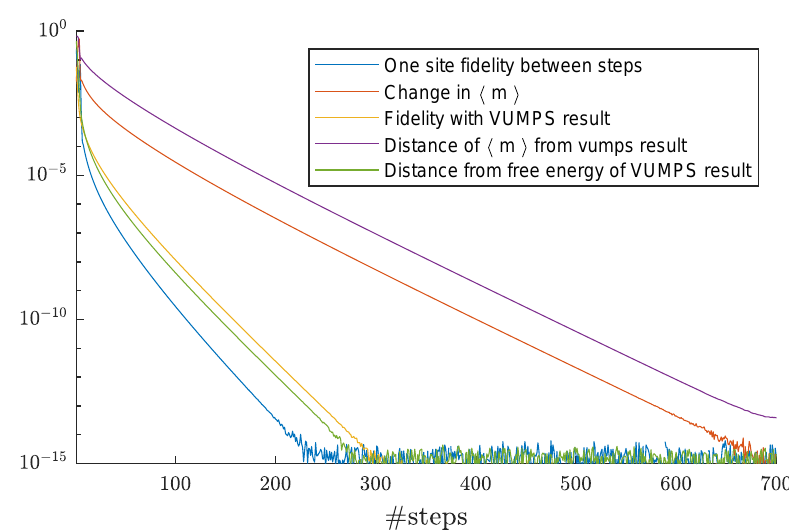
Figure 3: Different error measures to determine the convergence of the power method approach to find the MPS fixed point of the MPO transfer matrix of the an- tiferromagnetic Ising model at inverse temperature β = 1.01 β . From top to bottom c in the legend, we show (1) one minus the one site fidelity between site 1 and site 2 an iteration later, (2) the change in the local magnetization after an iteration, (3) one minus the fidelity with the sublattice rotated ferromagnetic vumps result, (4) differ- ence of the local magnetization with the one from the vumps result, (5) difference of the free energy with the one from the vumps